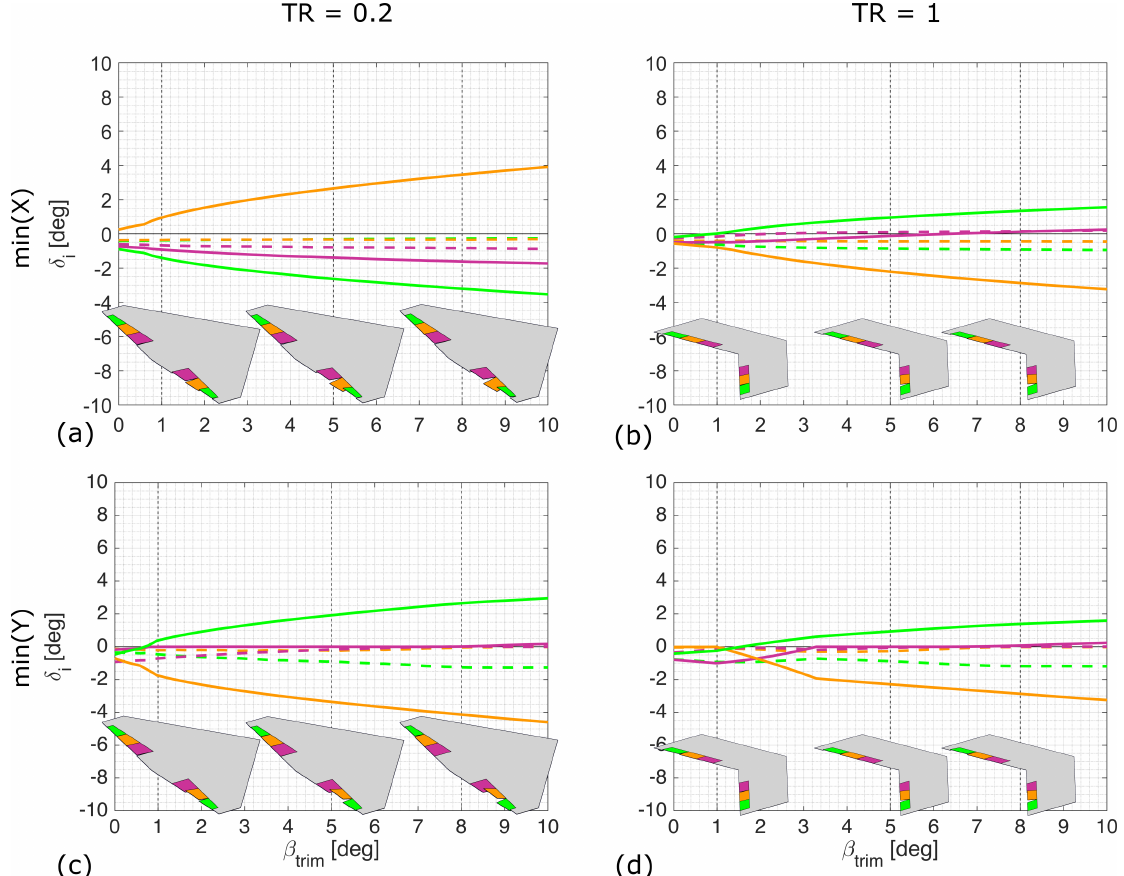
Figure 9. Deflection required to generate yawing moment to trim at sideslip for a 30 degree swept wing with objectives of maximising aerodynamic efficiency ( a , b ) and minimising aggregate control deflection ( c , d ) for a taper ratio 0.2 ( a , c ) and 1 ( b , d ). Dotted lines indicate port surfaces and solid lines are starboard surfaces, positive deflections trailing edge down. Inset shows deflections required to trim at one, five and eight degrees of